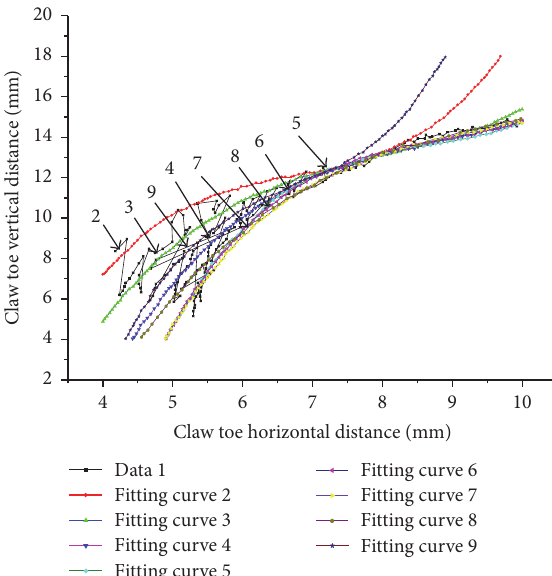
Figure 6: The polynomial fitting curves of the Himalayan marmot’s front claw contours.